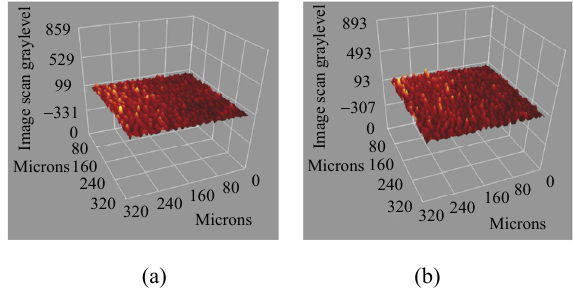
Fig. 5 Ellipsometer images: (a) MIP and (b) NIP SPR sensors surfaces.